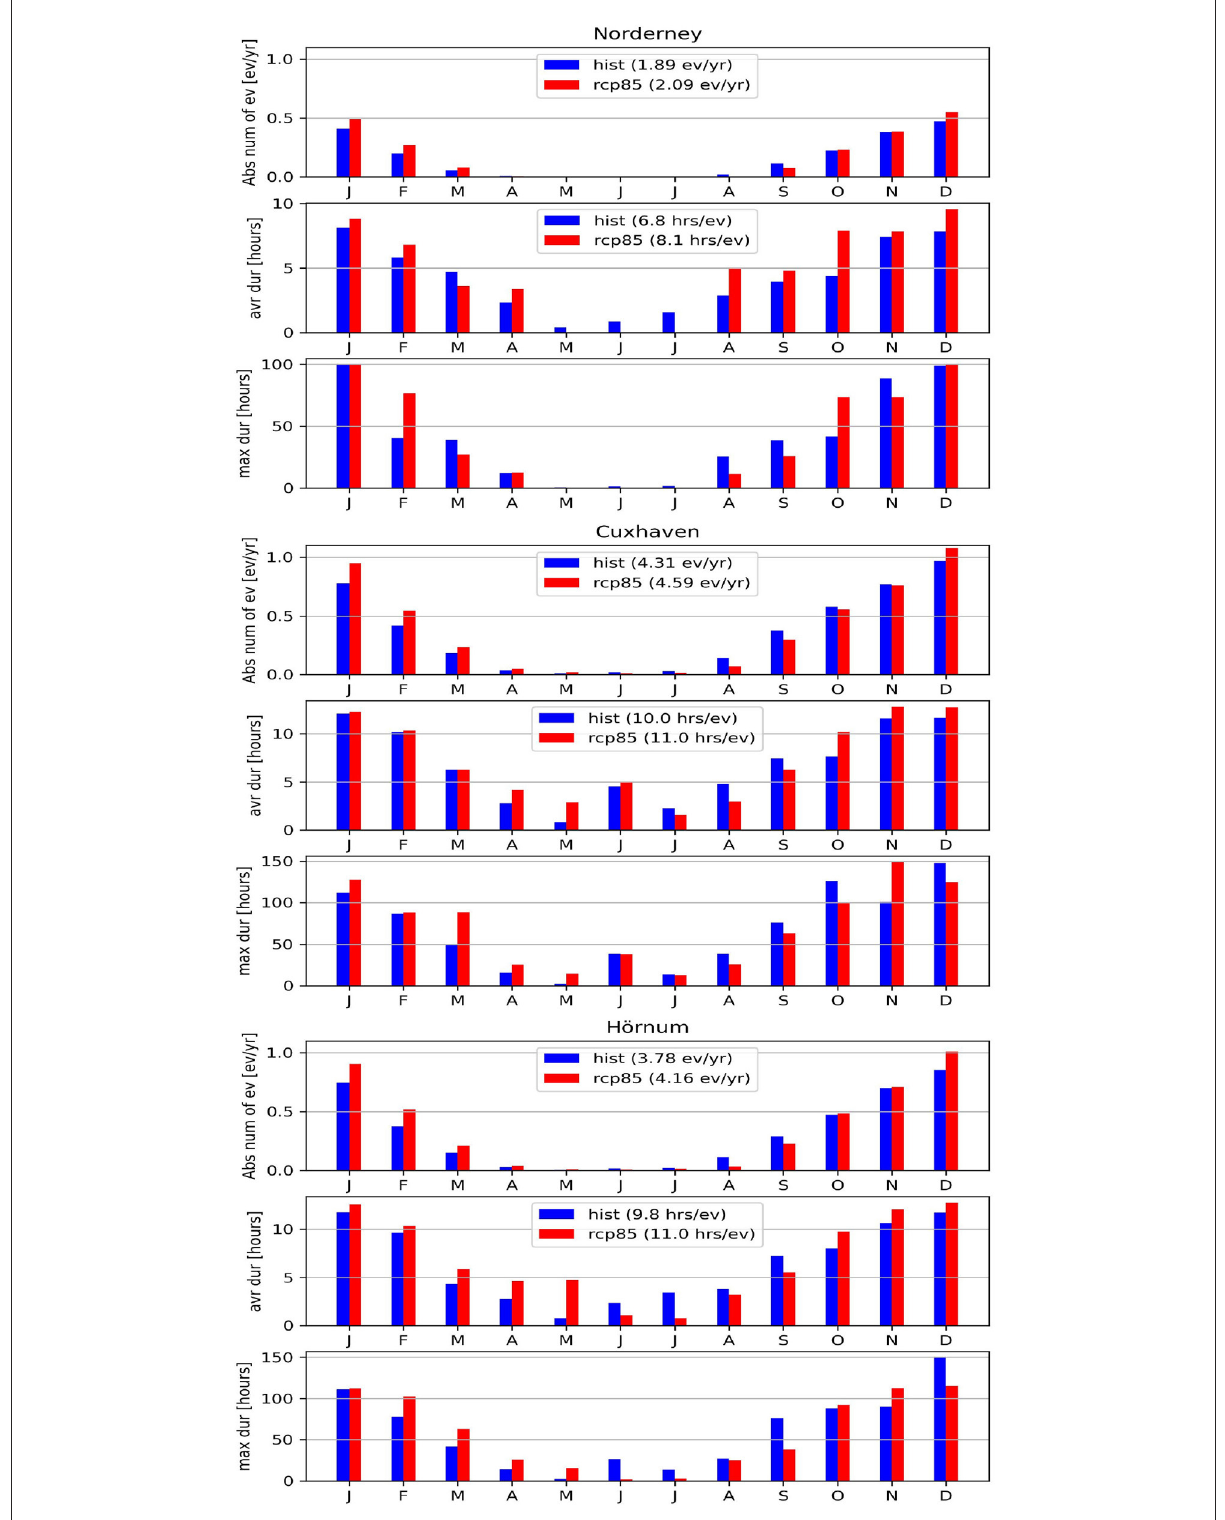
FIGURE7 Clustered storm surge events (all types) for each month of a year at Norderney, Cuxhaven, Hörnum. ( First panels) absolute frequencies; ( middle and lower panels) average and maximum duration. Numbers in legends are calculated over all events in the corresponding pools.